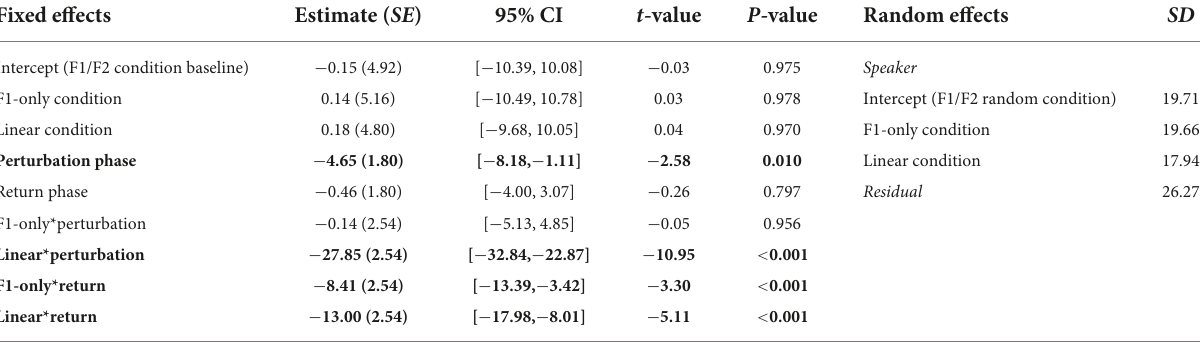
TABLE 1 Coefficients from the Best-Fit Model used to predict speakers’ normalized F1 values during Experiment